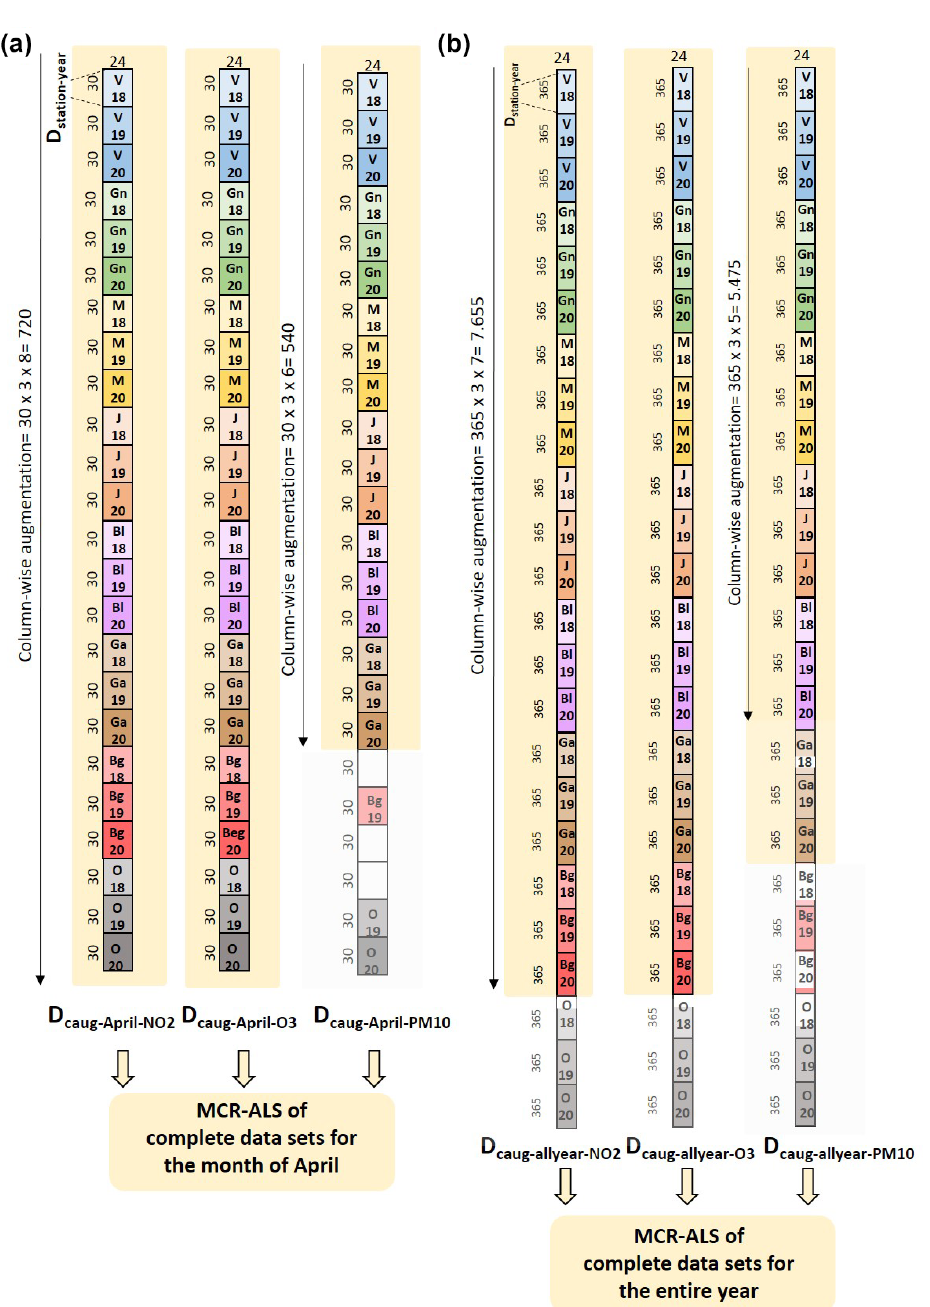
Figure 1. Data arrangement for individual analysis of completed data sets. Concentrations of NO 2 , O 3 , and PM 10 in the month of April (a) and the entire year, for one year and one station (b) can be arranged in a data matrix with the days in the rows and the 24h measurements in the columns D station-April or D station-year . These individual data matrices are arranged in three (one per each pollutant) column-wise augmented data matrices. For the data set of April in 2018–2019–2020 (a) , the augmented matrices are D caug-April-NO 24) and D caug-April-PM (540, 24). For the data set of the entire year in 2018–2019–2020 (b) , the augmented matrices are D caug-allyear-NO 10 D caug-allyear-O (7655, 24) and D caug-allyear-PM (5475, 24). Stations containing missing data (white gaps in the figure) are excluded for 3 10 further MCR-ALS analysis (yellow-shaded area). VH: Vall d’Hebron, Grn: Granollers, Mn: Manlleu, Jun: Juneda, Bell: Bellver, Gra: Gràcia, Beg: Begur, OF: Observatori Fabra.